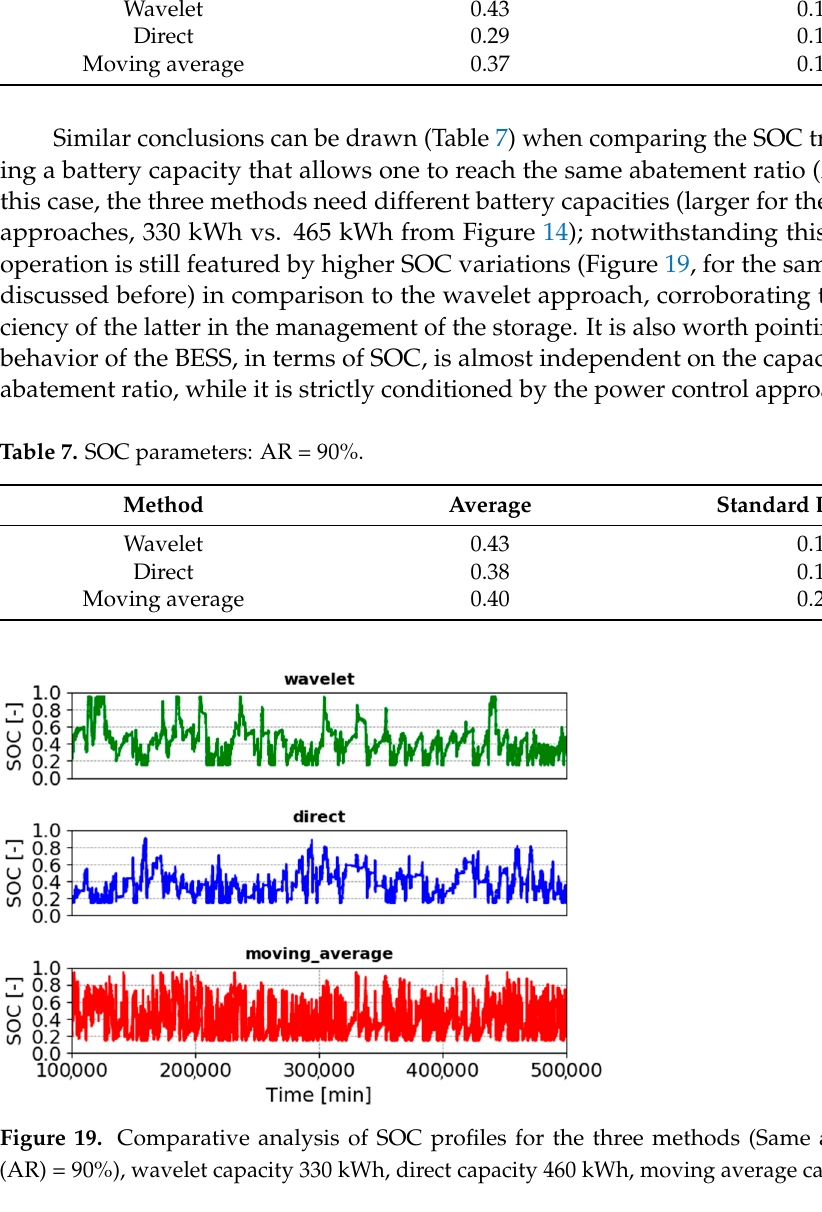
Table 7. SOC parameters: AR =